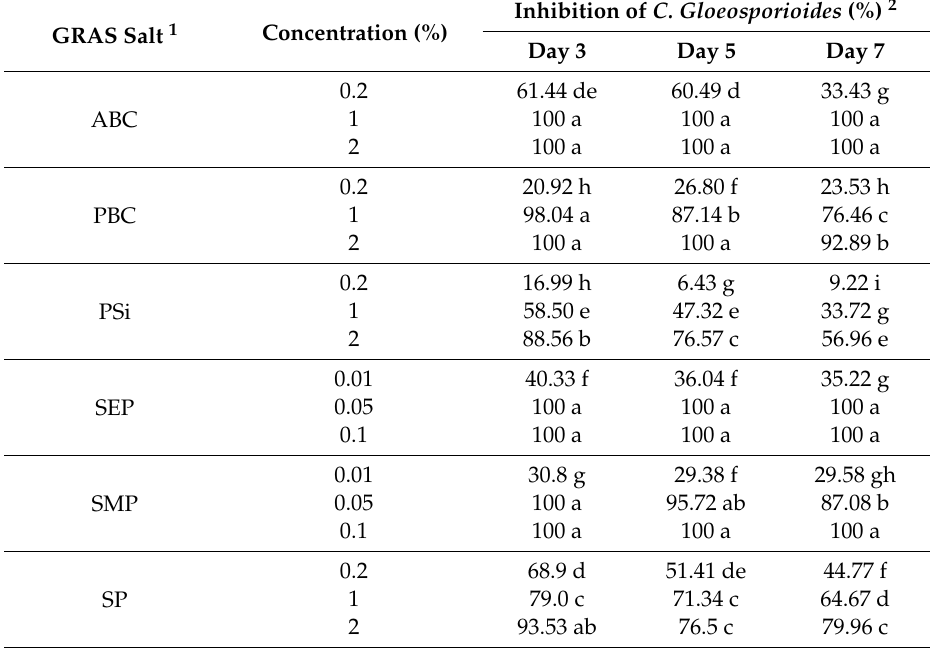
Table 2. Percentage of radial growth inhibition of Colletotrichum gloeosporioides on PDA Petri dishes amended with GRAS salts at di ff erent concentrations after 3, 5 and 7 d of incubation at 25 ◦ C. GRAS Salt 1 Concentration